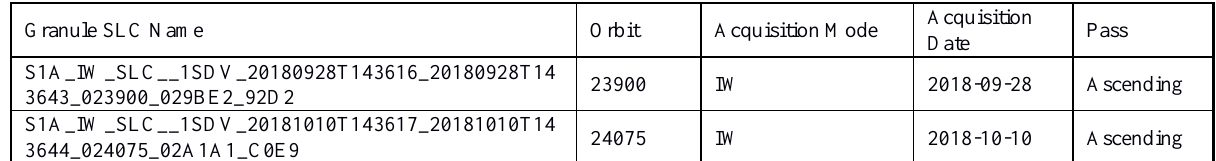
Table 1: Single Look Complex (SLC) of Sentinel-1A images properties of the study area.